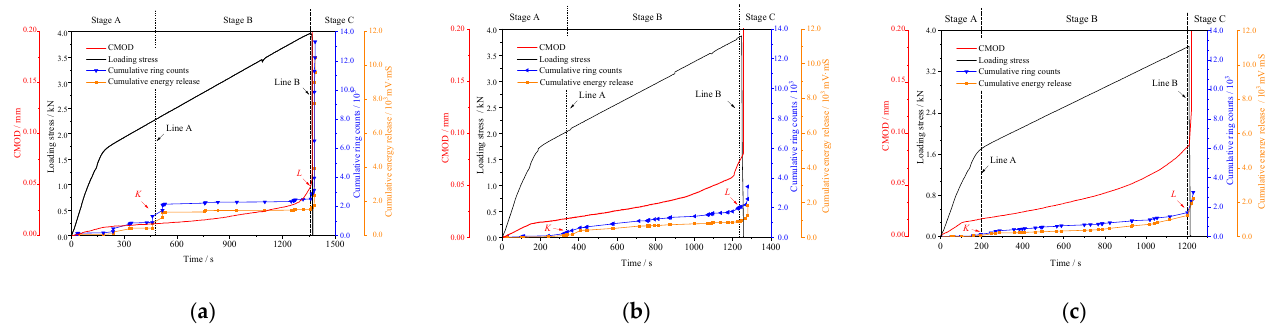
Figure 14. AE signal–time and stress–time curves of concrete with different graphite powder content during three-point bending test. ( a ) B1; ( b ) B2; ( c ) B3.